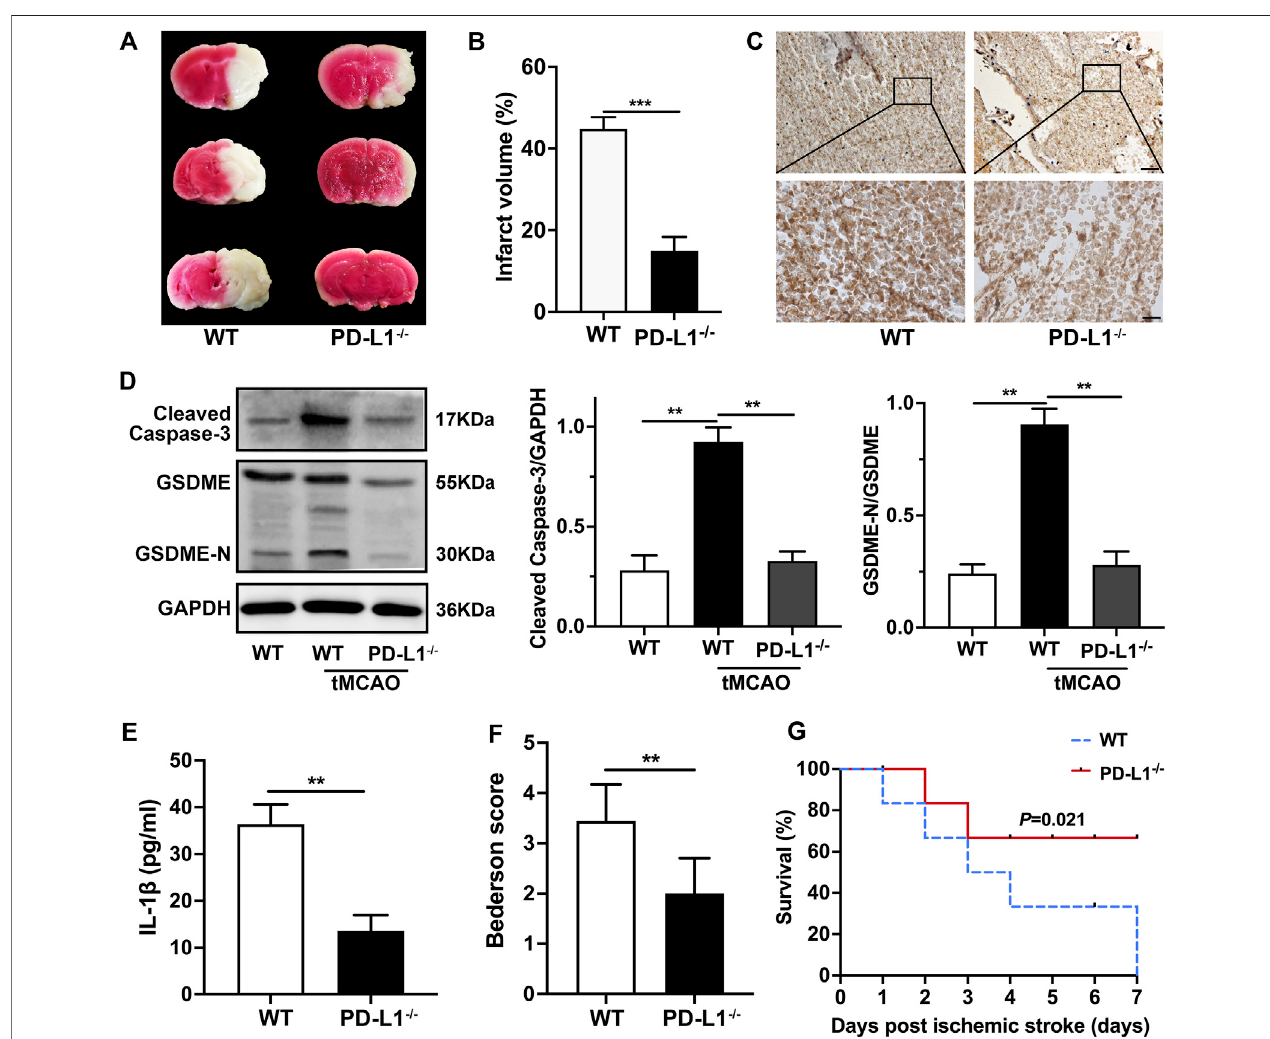
FIGURE 6 | Knockout PD-L1 ameliorates ischemic stroke and improves neurological function through Caspas-3/GSDME signaling. (A) Representative images of three corresponding coronal sections of 2,3,5-triphenyl tetrazolium chloride – stained brains from PD-L1 − / − mice and WT mice 24 h after tMCAO; n = 7. (B) Brain infarct volumes of WT mice and PD-L1 − / − mice 24 h after tMCAO; n = 7. (C) Extract cerebral thrombus from WT and PD-L1 − / − mice 24 h after tMCAO. Platelets were stained with CD42b (brown). The images show a representative immunohistochemical stained section of mouse cerebral thrombosis. Bar represents = 50 μ m (up). Bar represents = 10 μ m (down). n = 6. (D) Representatives immunoblot of the GSDME in platelets of WT mice and PD-L1 − / − mice 24 h after tMCAO. GAPDH was used as loading controls. n = 6. (E) The levels of platelets IL-1 β in WT and PD-L1 − / − mice 24 h after tMCAO were detected by enzyme-linked immunosorbent assay. n = 6. (F) Bederson score re fl ecting global neurological defects (0 indicates best, three indicates worst) of WT mice and PD-L1 − / − mice 24 h after tMCAO; n = 7. (G) Analysis of survival of PD-L1 − / − mice (red line) and WT mice (blue line) 7 days after ischemic stroke; n = 7 – 9. Data are mean ± SD. * p < 0.05, ** p < 0.01, *** p < 0.001.